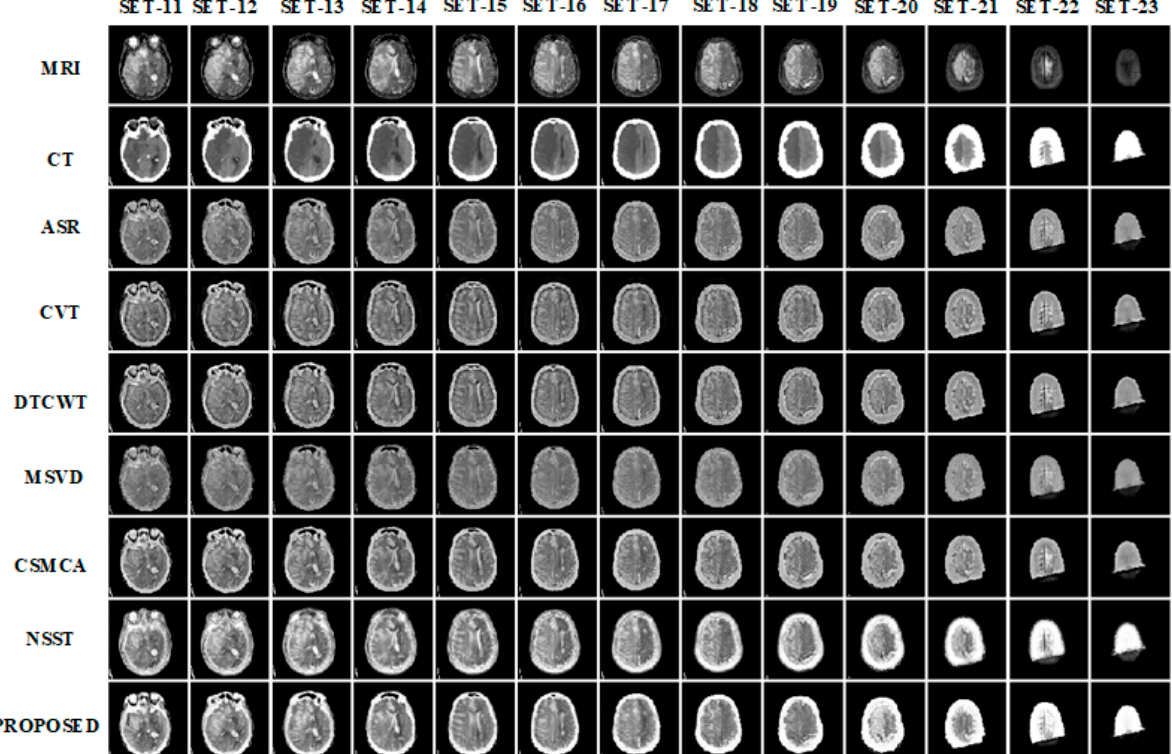
Figure 8. The results of various methods on first 10 pairs of MRI-T images (fatal stroke).